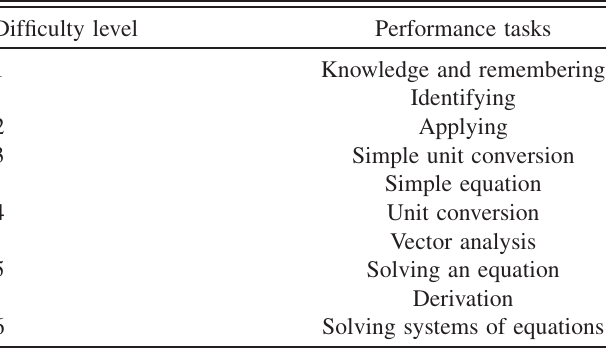
TABLE I. Classification of performance tasks by means of difficulty